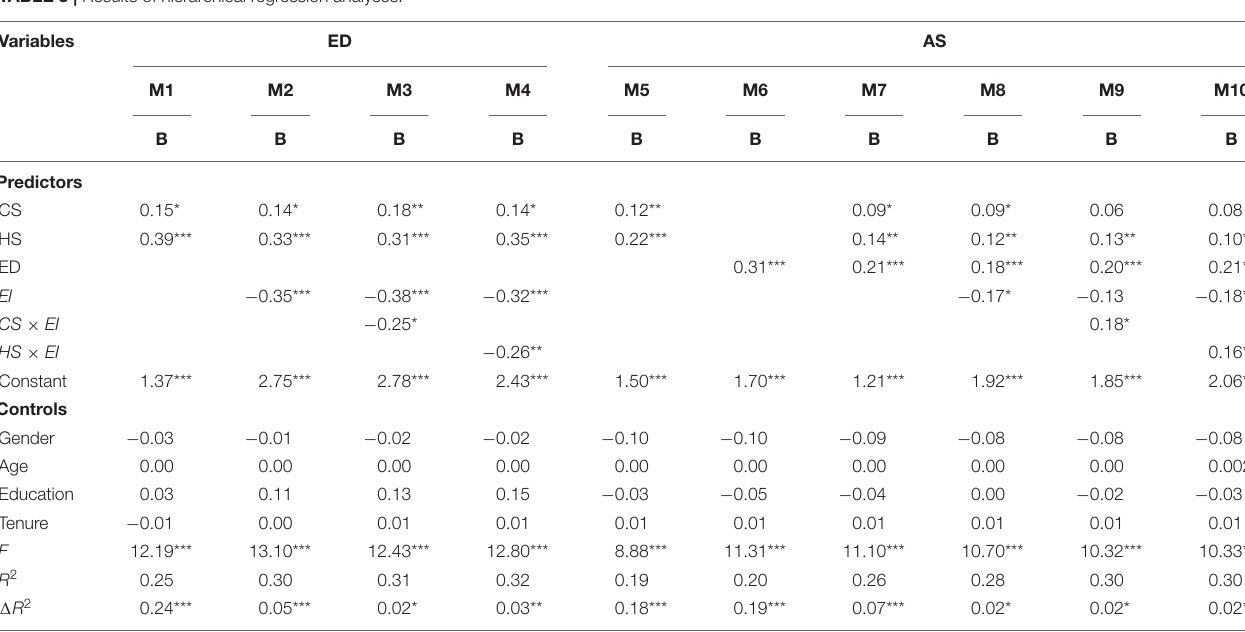
TABLE 3 | Results of hierarchical regression